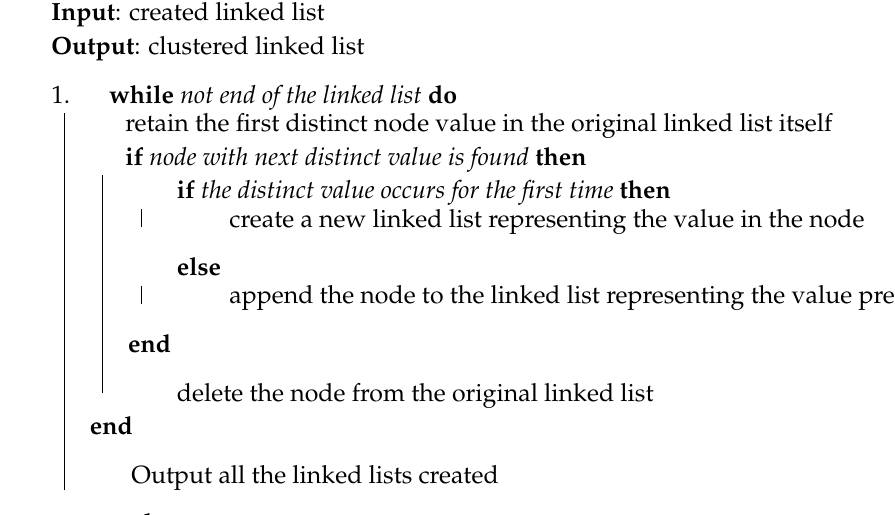
Algorithm 2: Clustering by traversing the linked